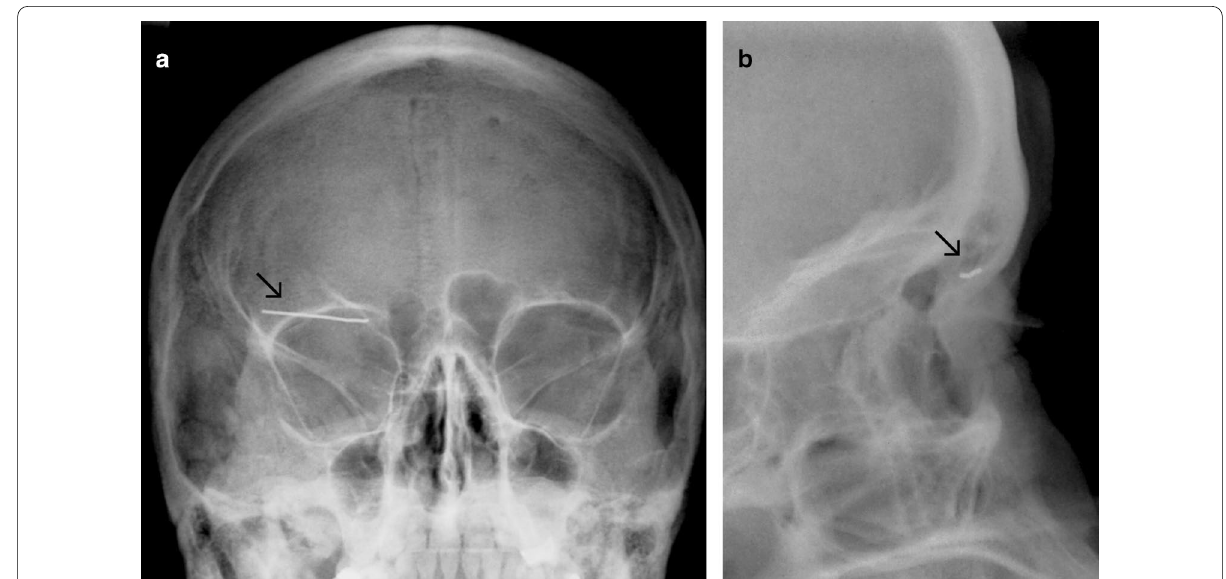
Fig. 6 Paper clip. Anteroposterior ( a ) and lateral ( b ) radiographs showing a linear radiopaque structure in projection of the upper eyelid (arrow)